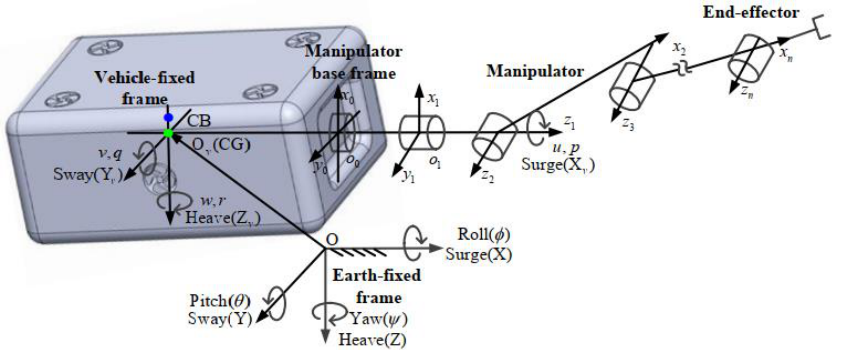
Figure 1. The coordinate frames of the UVMS. Table 1. Nomenclature for the underwater vehicle. Variable